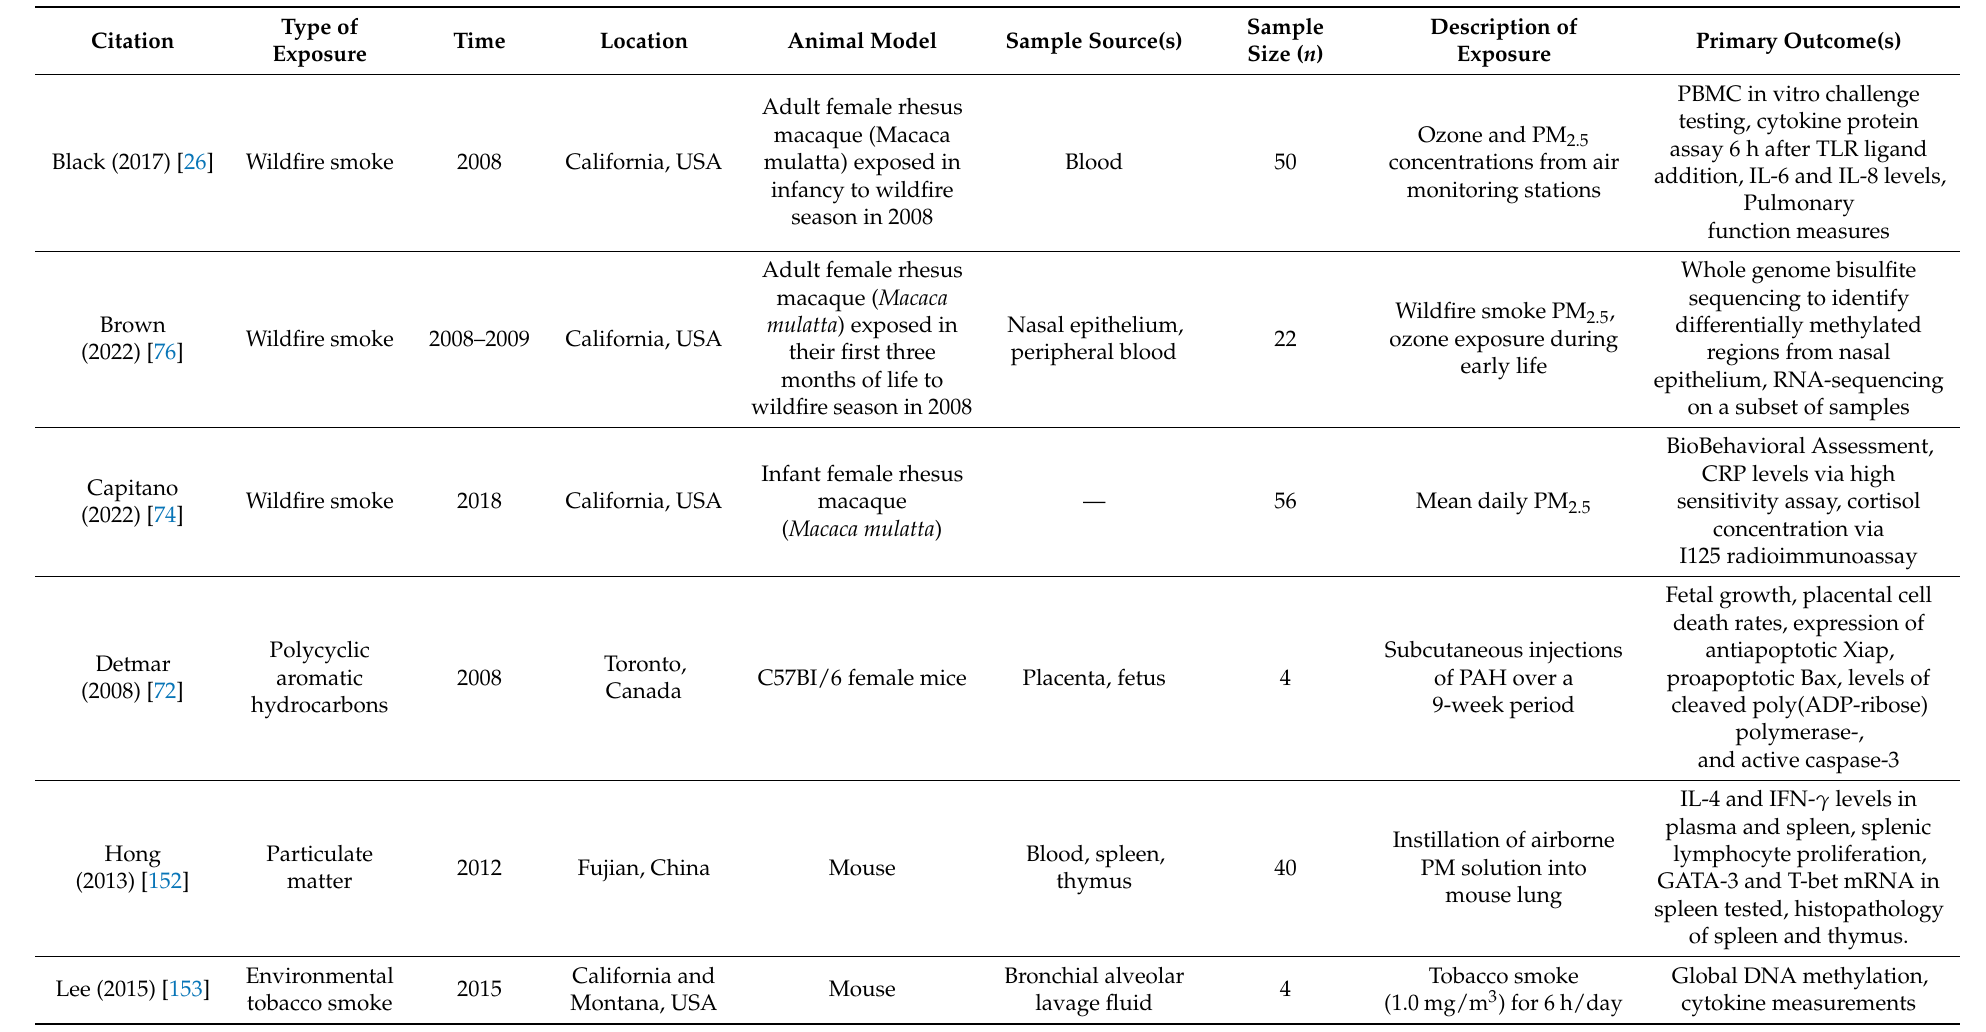
Table 2. Summary of animal studies included in our review. For each study, we provide the citation, type of exposure, time frame, location, animal model, and sample size. We also provide a description of the exposure. Finally, we indicated the primary outcome observed. Citations are listed in alphabetical